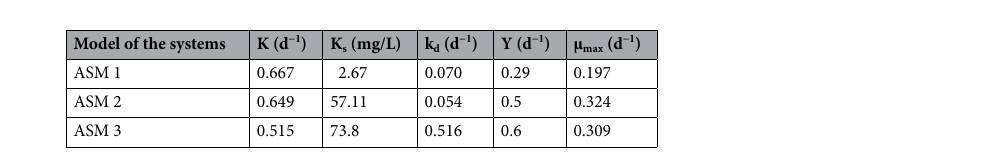
Table 7. The biokinetic coefficients